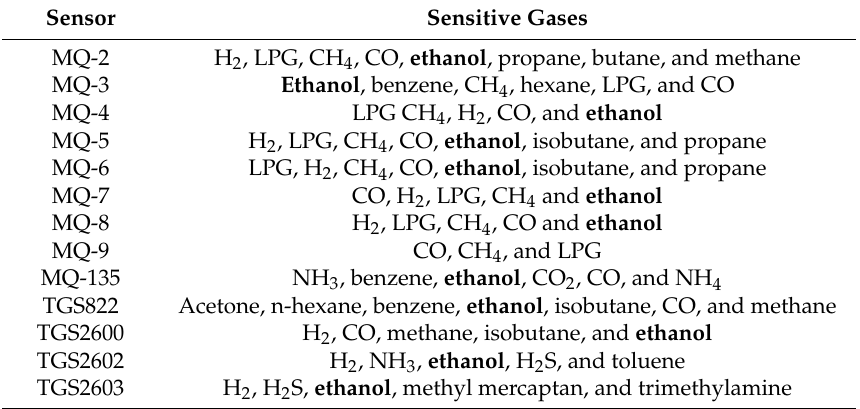
Table 1. Sensors used in the experiments and their sensitive gases.